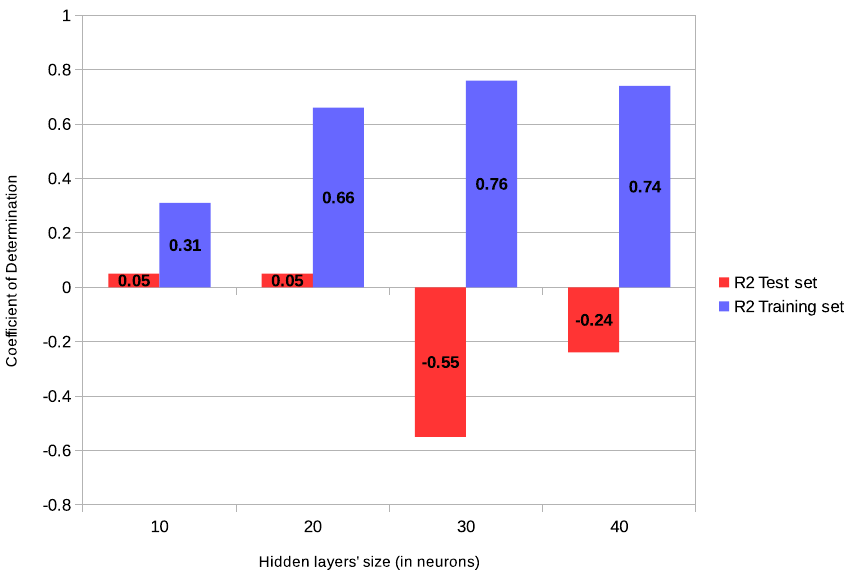
Figure 4. Regression model for primal method—tuning the activation function.